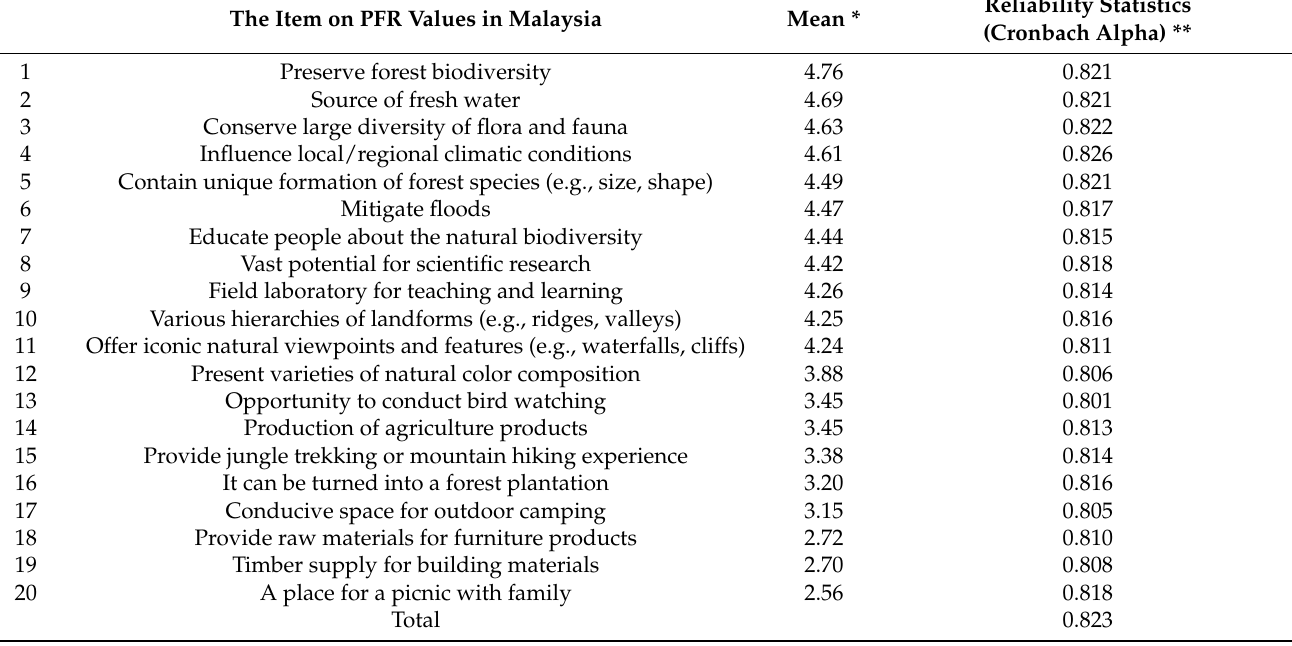
Table 6. Means and reliability statistics for values of the preservation of PFRs in